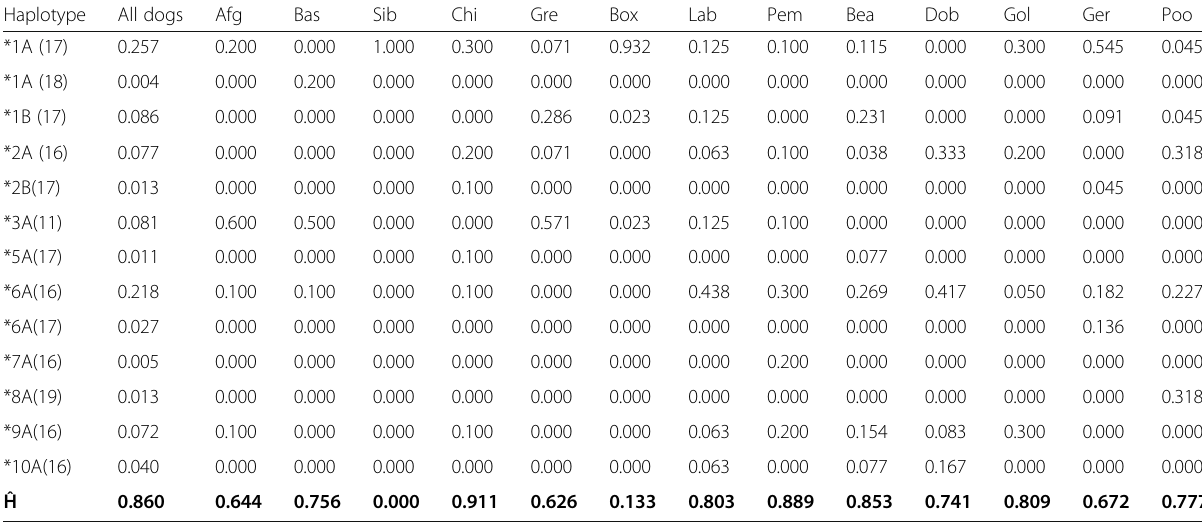
Table 4 Comparison of GSTP1 promoter haplotype frequencies between different dog breeds Haplotype